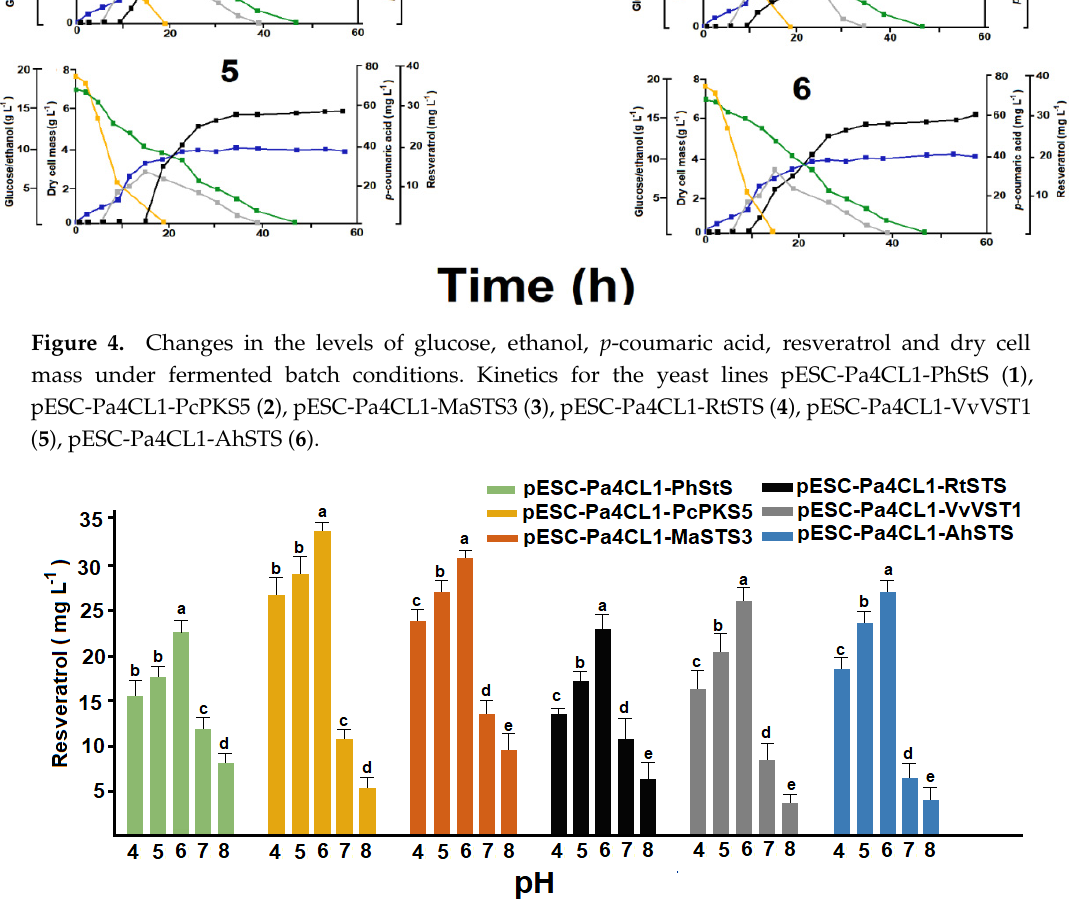
Figure 6. Conversion of p -coumaric acid into resveratrol by recombinant strains of S. cerevisiae containing six stilbene synthases growing at pH 6. Different letters indicate statistically significant differences ( p < 0.01). Error bars represent standard deviation of ten independent experiments (n = 10). Interestingly, a different capacity to produce resveratrol was observed in each strain evaluated. Under the assayed conditions, pESC-Pa4CL1-PhStS had a similar activity to pESC-Pa4CL1-VvVST1, whereas a comparable activity was observed between pESC-Pa4CL1-MaSTS3 and pESC-Pa4CL1- AhSTS to produce resveratrol (Table 2). Among the six strains assayed, pESC-Pa4CL1-PcPKS5, pESC- Pa4CL1-MaSTS3 generated more resveratrol levels after the addition of 70 mg L − 1 p -coumaric acid. Despite the enzymatic activity of individual STS should be strongly involved in this results, other intrinsic factors that influence the synthesis and regulation of heterologous enzymes in S. cerevisiae